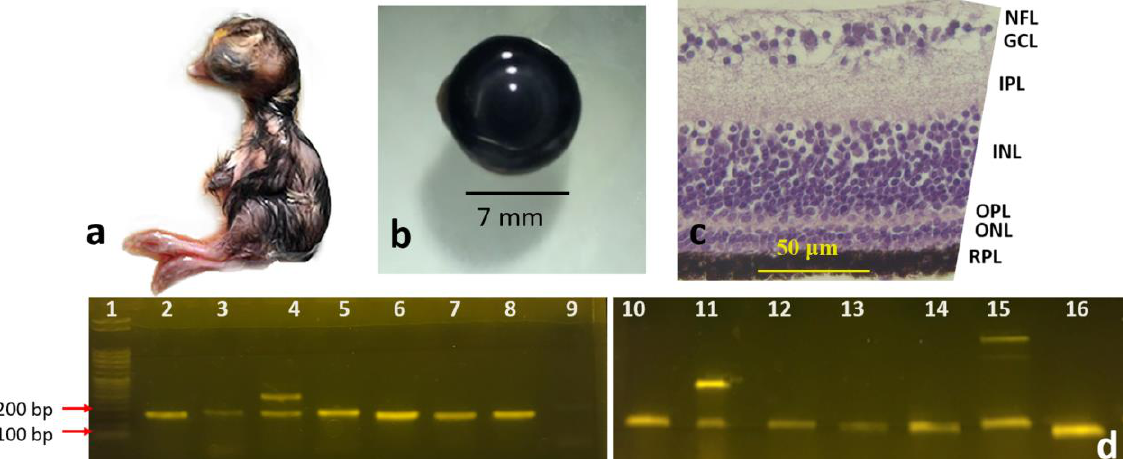
Figure 2. Fifteen-day chick embryos: ( a ) whole Embryo, ( b ) the retrieved eye, ( c ) cross section of the retina (20X); scale bar = 50 μm ( d ) RT-PCR of the different genes labeled as follows: 1: 100 bp DNA